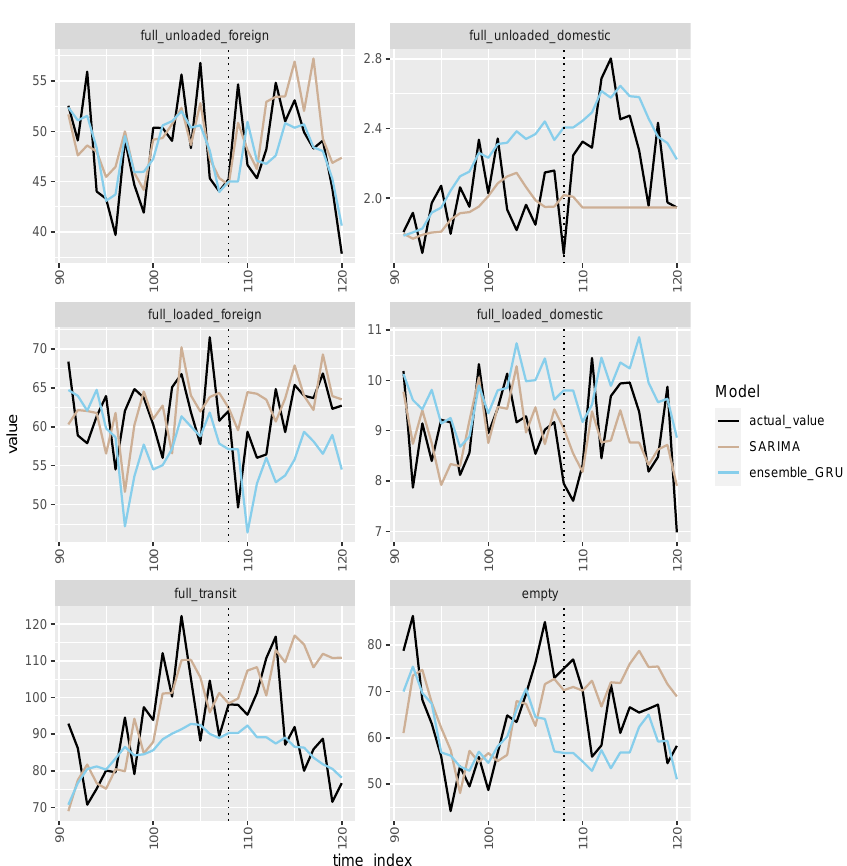
Figure 7. Time series predictions of GRU and SARIMA